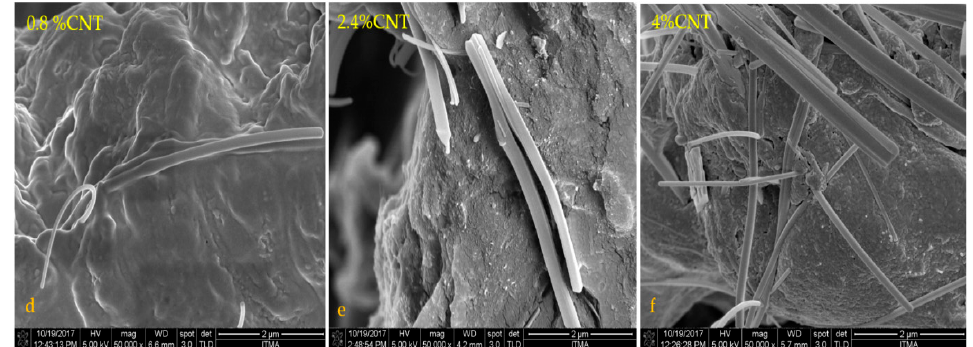
Figure 5. Field-emission scanning electron microscopy (FE-SEM) micrograph of ( a ) neat PLA, ( b ) PLA/PEG blend, ( c ) MWCNT powder, and the images of composite films with different MWCNT content ( d ) 0.8 wt.% MWCNT, ( e ) 2.4 wt.% MWCNT, and ( f ) 4 wt.% MWCNTs.